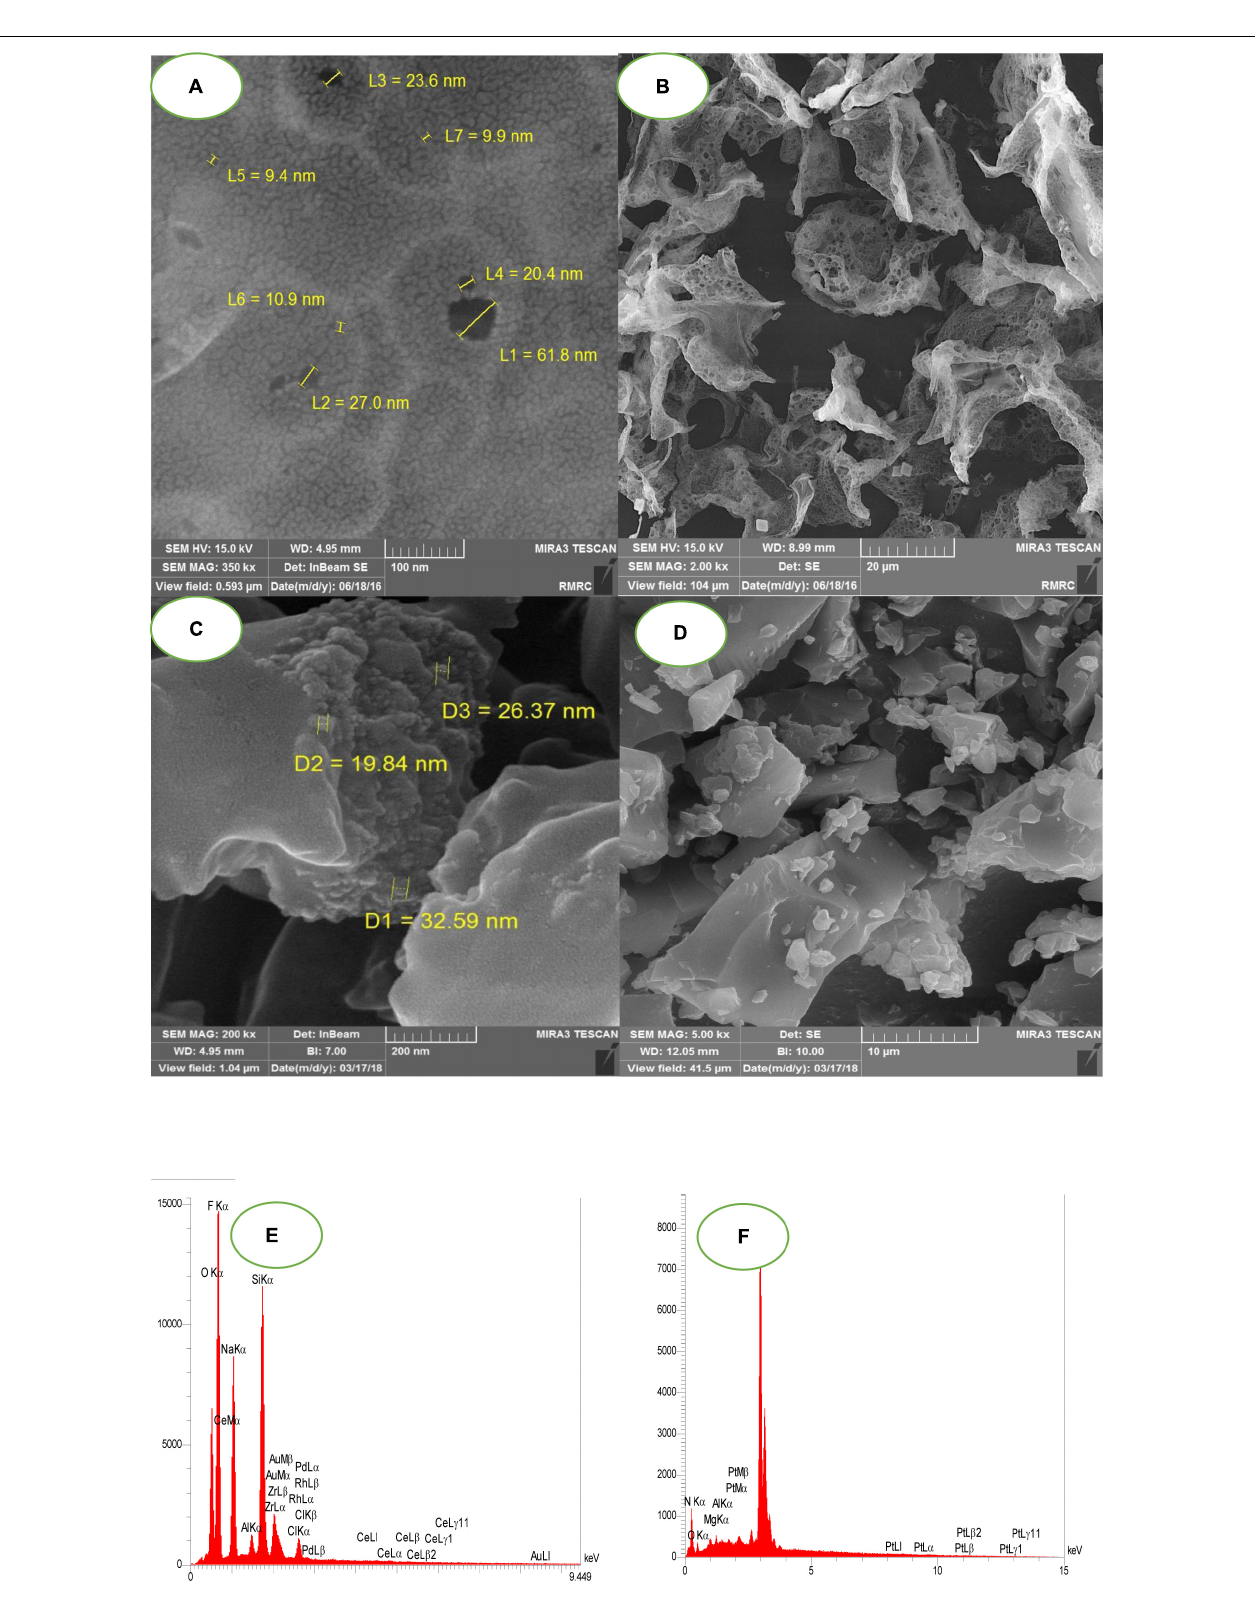
FIGURE 1 | SEM images of (A,B) pristine MMO, (C,D) MMO-PEI-60, EDS analysis of recycled multi-metal oxide prepared from the spent car catalytic converter (E) and EDS analysis of 60 wt.% PEI loading (F) .